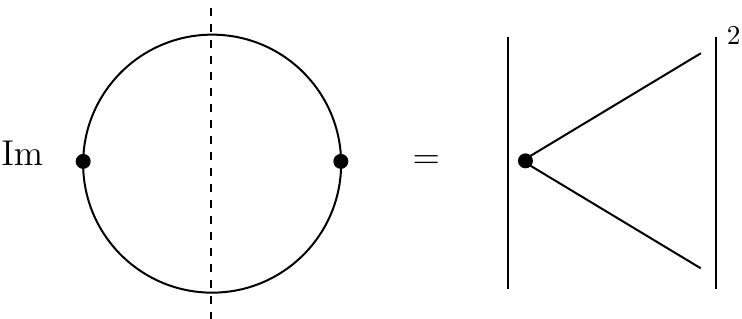
Figure 1. Extraction of imaginary part of Green’s function using ordinary Cutkosky cutting rules. The on-shell propagators are thermal, with individual contributions to the right hand side illustrated in (cid:12)gure